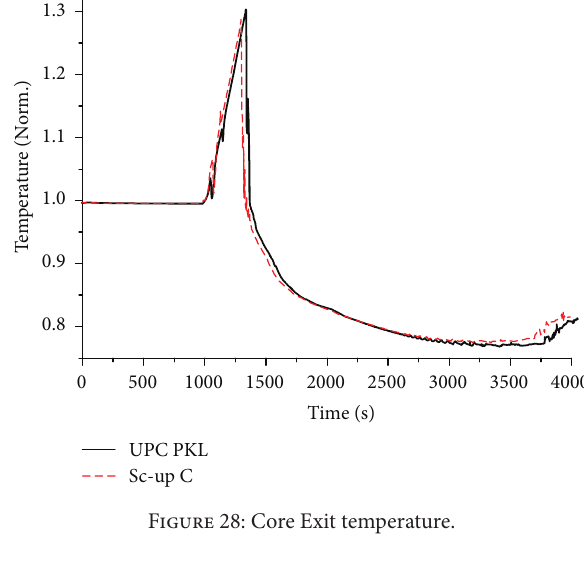
Figure 26: Break mass flow rate.